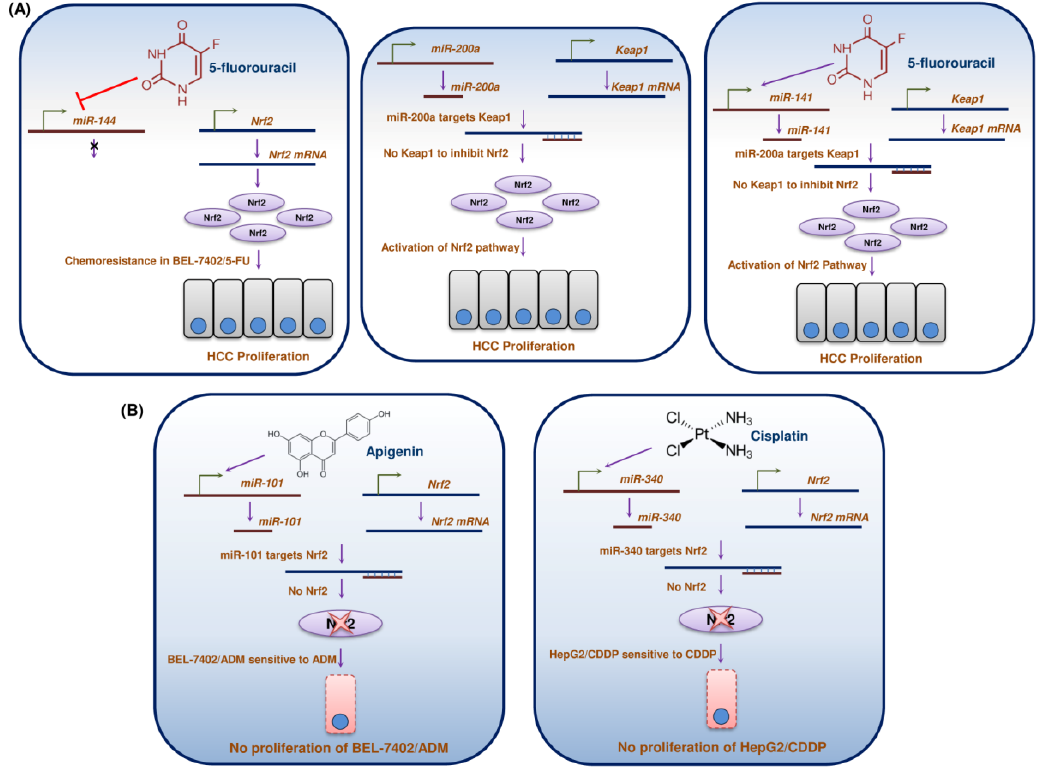
Figure 7. MiRs in the regulation of Nrf2 in HCC. MiRs either ( A ) activate or ( B ) suppress Nrf2, leading to chemoresistance and chemosensitization of HCC.